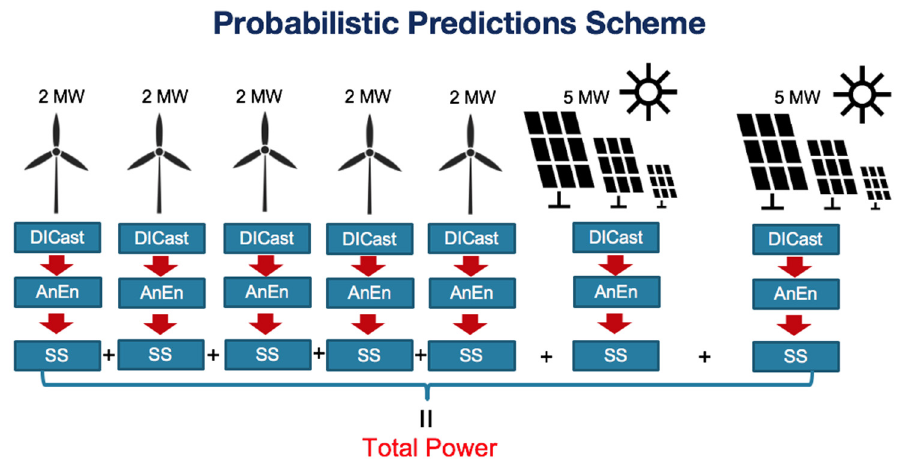
Figure 2. Scheme of the probabilistic forecasting system built for the Shagaya plant. DICast: Dynamic Integrated Forecast System; AnEn: analog ensemble; SS: Schaake Shuffle.